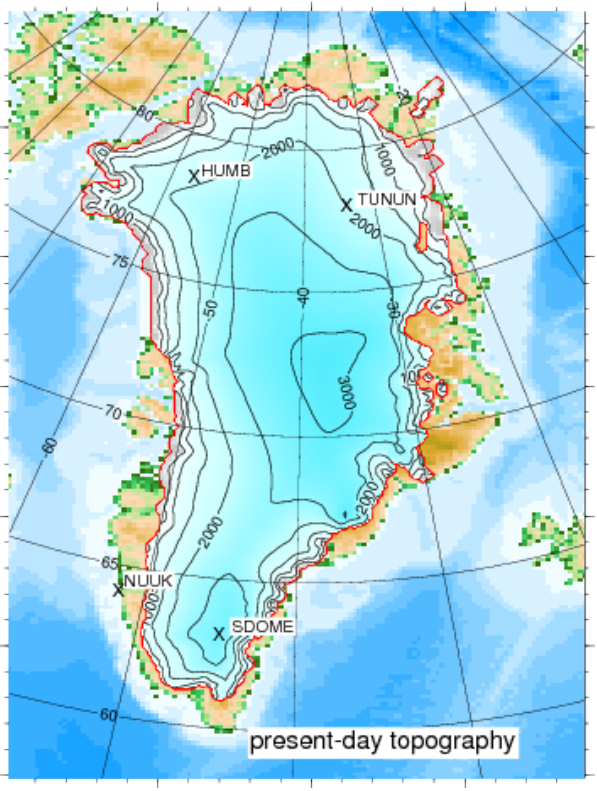
Fig. 1. Present day topography of the GIS, used to initialise the ISM. Selected weather stations are represented.